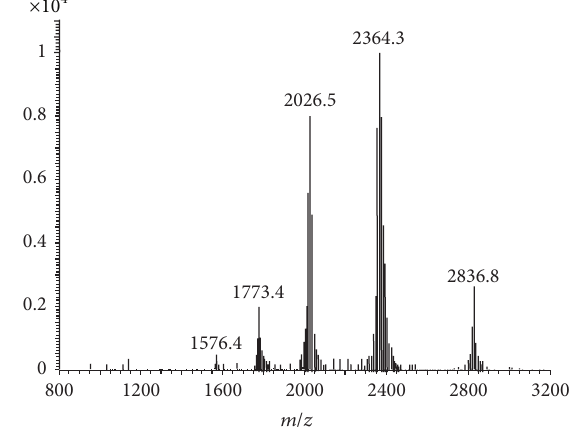
Figure 1: The original mass spectra of bovine 𝛼 -La.